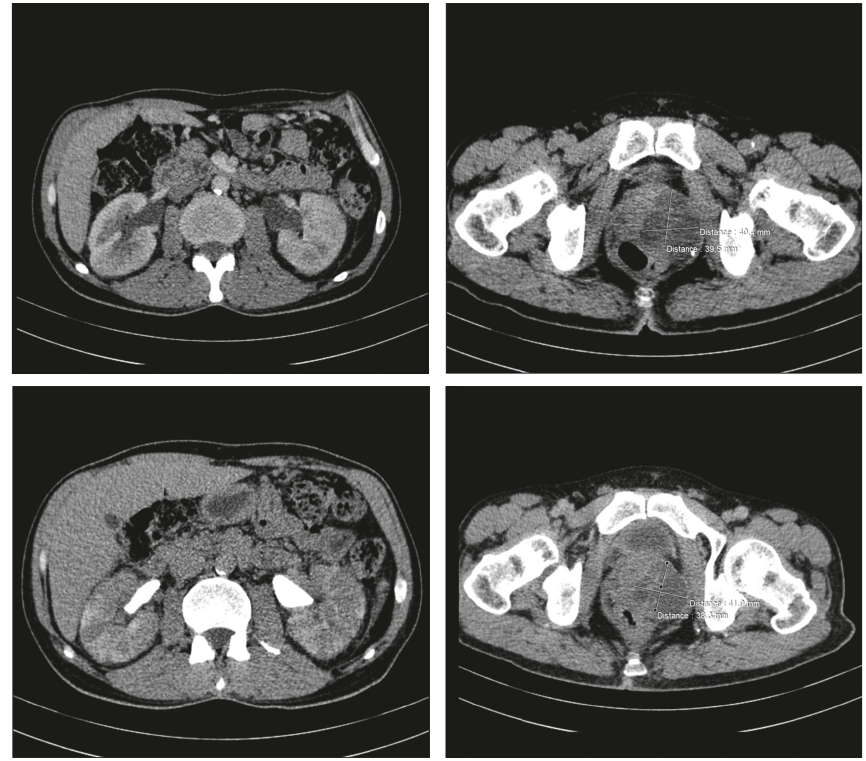
Figure 2: Tomodensitometric views showing prostatic abscess with bilateral ureterohydronephrosis.